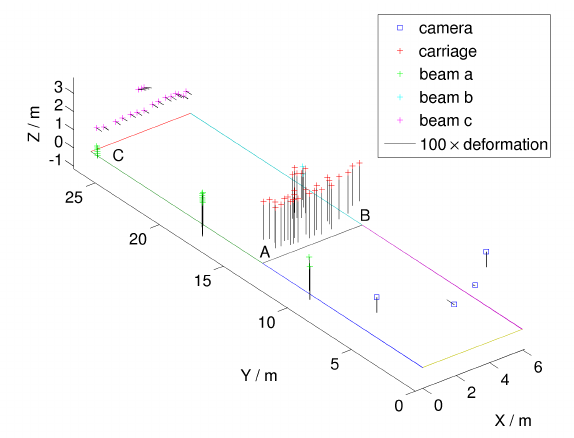
Figure 4: Direction and 100 times the magnitude of movement of target points and camera locations due to object deformation.